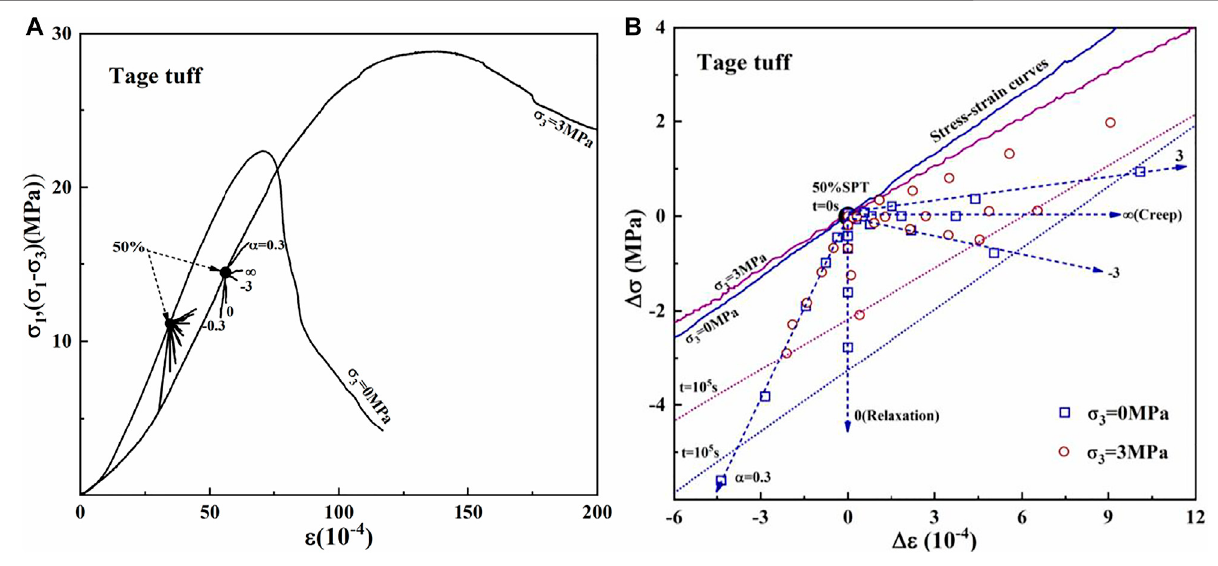
Frontiers in Earth Science |